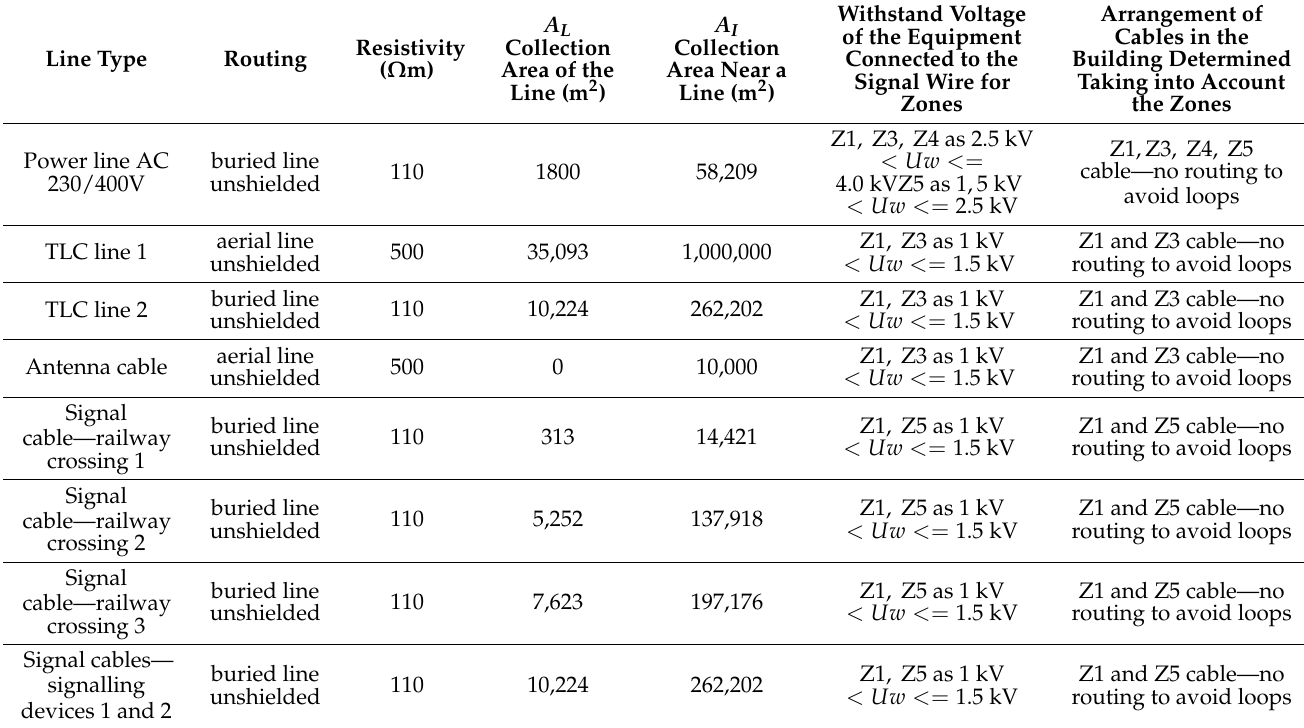
Table 3. The lines entering into the Signal box and going out of it